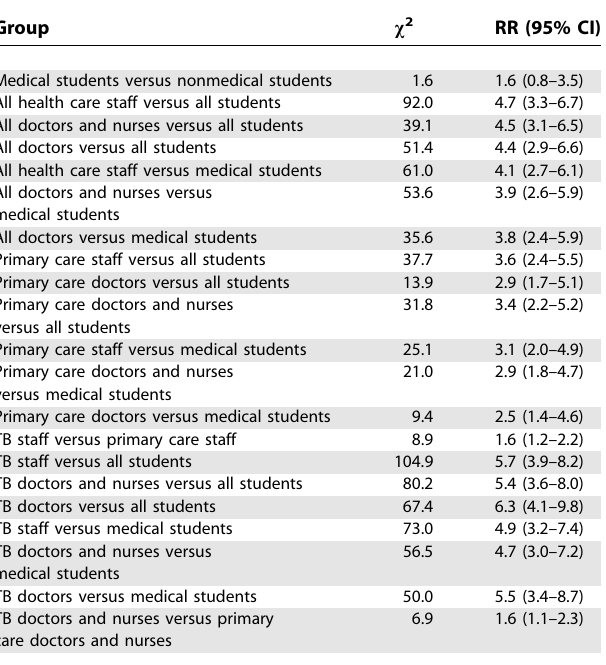
Table 3. Relative Risk (%) and 95% Confidence Intervals of LTBI Positivity (IFN- c ) by Exposure Group, Samara Oblast Group v 2 RR (95%